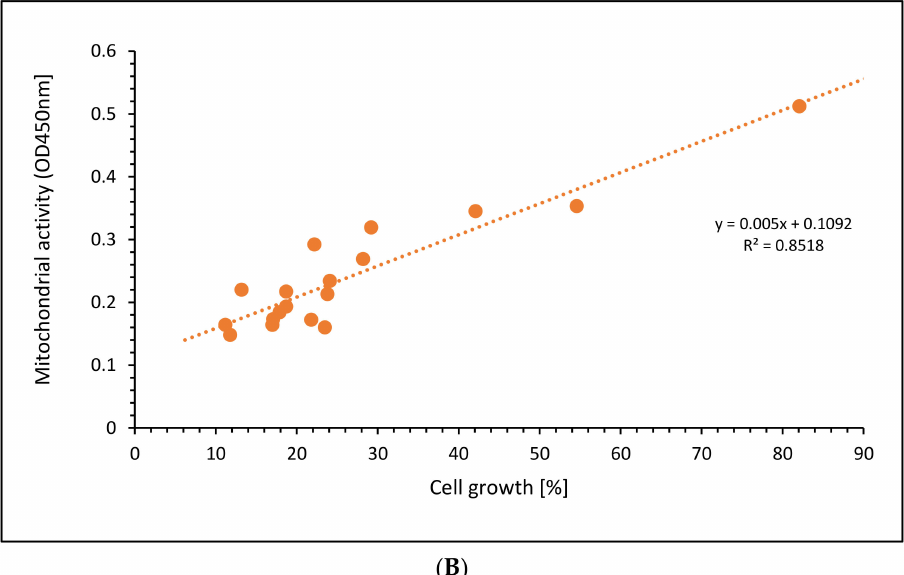
Figure 6. Regression of cell growth against mitochondrial activity using different concentrations of ( A ) aKG or ( B ) 5-HMF on Jurkat cell